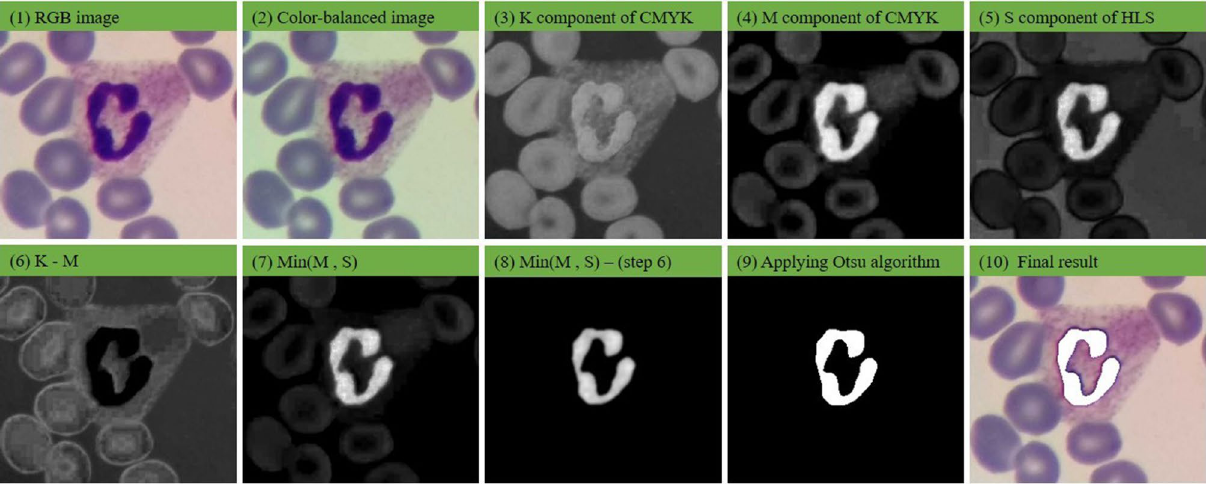
mean of grayscale image mean of old component